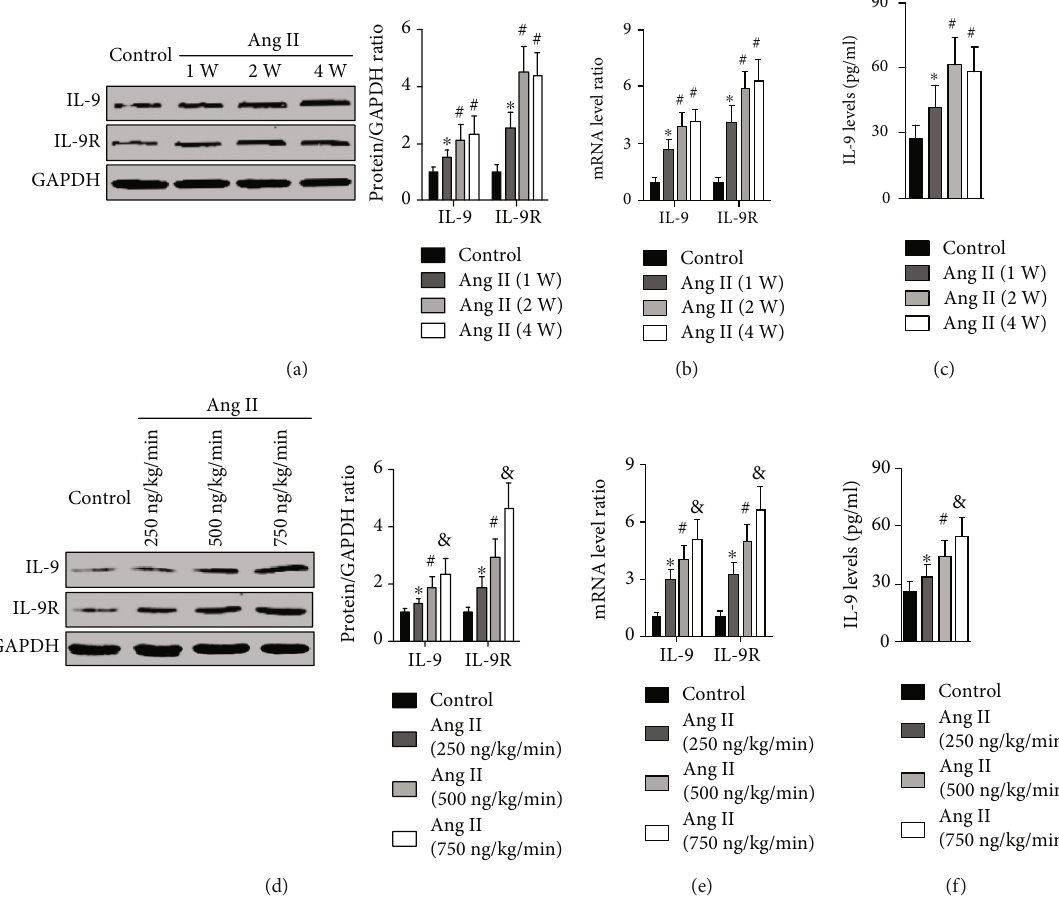
Figure 1: E ff ects of Ang II treatment on IL-9 expression. (a) Aortic IL-9 and IL-9R expressions were measured at di ff erent time points of Ang II infusion. (b) Aortic mRNA expression of IL-9 and IL-9R of each group was determined. (c) Serum IL-9 levels were detected at each time point. (d) Aortic IL-9 and IL-9R expressions were investigated at di ff erent doses of Ang II at the end of four weeks. (e) IL-9 mRNA and IL-9R mRNA in aortas of mice treated with di ff erent concentrations of Ang II were detected. (f) Serum IL-9 levels were determined when di ff erent Ang II doses were administered. N = 5 ‐ 6 for each group. ∗ p < 0 : 05 vs. the control group; # p < 0 : 05 vs. the Ang II (1 W) group or the Ang II (250ng/kg/mini) group; & p < 0 : 05 vs. the Ang II (500ng/kg/min)